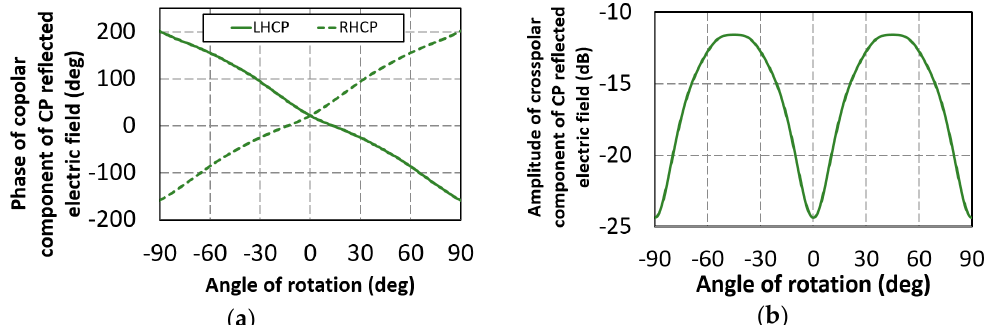
Figure 4. Electromagnetic response provided by the unit cell at 19.7 GHz with fixed values of L 2 = 4.9 mm and L 1 = 6.025 mm as a function of rotation angle. ( a ) Phases of the reflected electric fields of the co-polar circularly polarized waves. ( b ) Amplitude of the reflected electric field of the cross-polar circularly polarized wave for a right-handed circularly polarized (RHCP) incident wave.